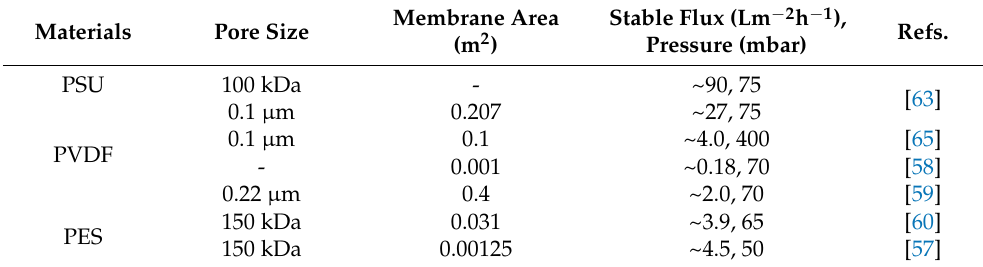
Table 2. Impact of membrane properties on the membrane performance in gravity-driven mem- brane filtration.